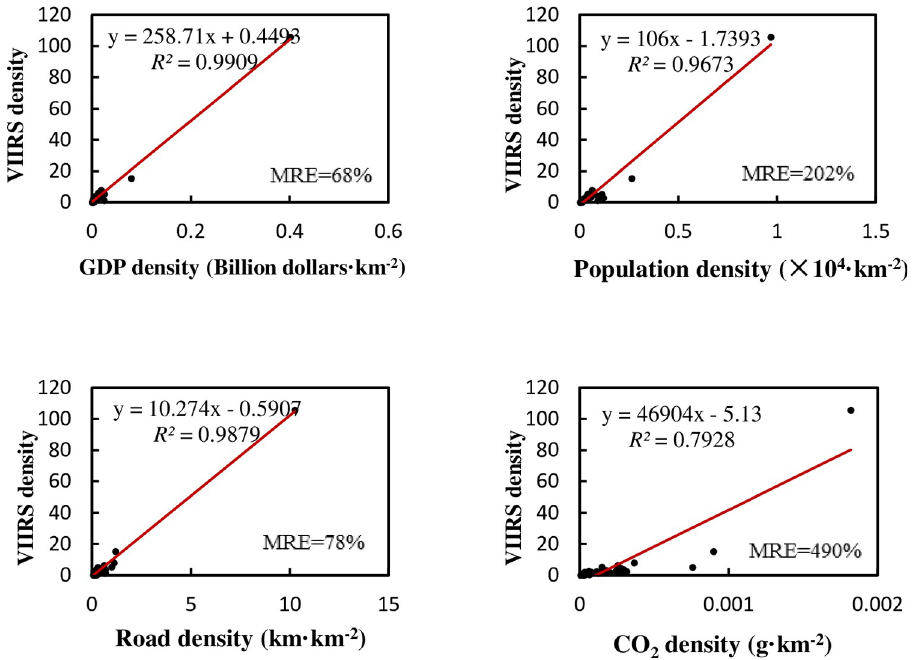
Fig 7. Regression relationship between NTL density and density of various elements in state-level administrative regions of India.